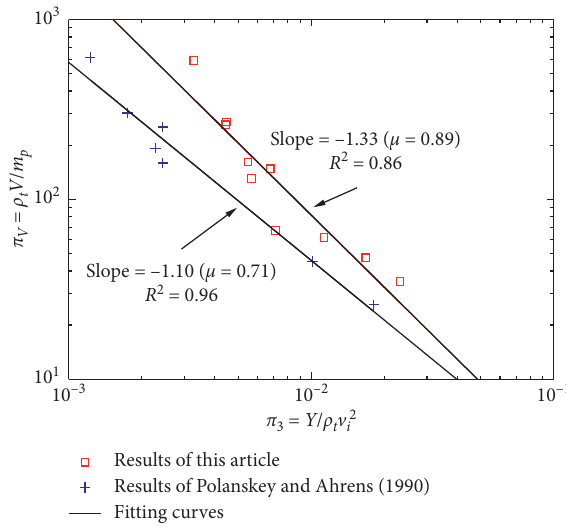
Figure 14: The relationship of dimensionless π